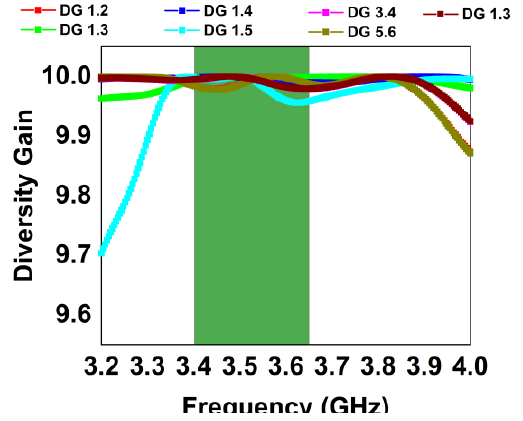
Figure 11. Diversity gain.